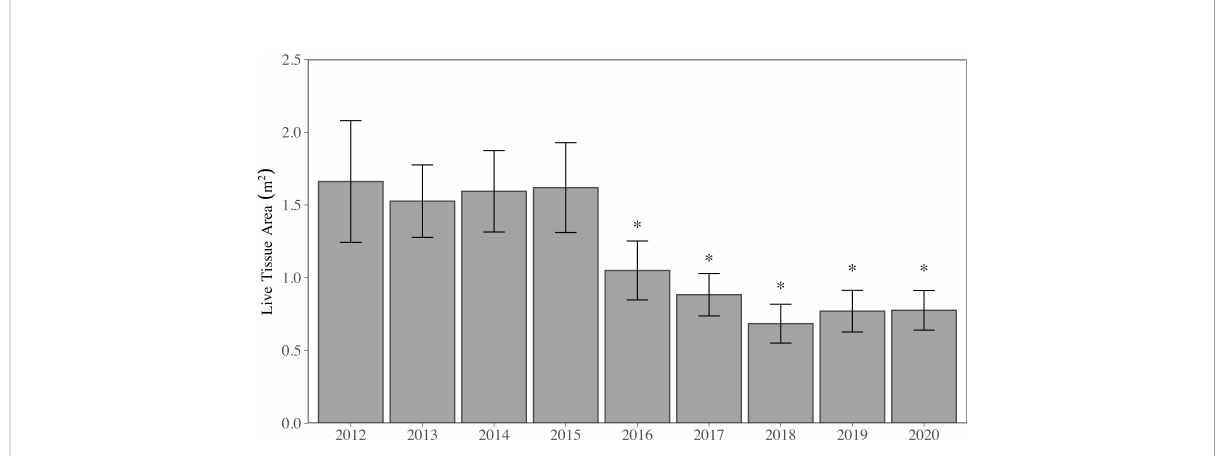
FIGURE 2 Mean (± SE) annual live tissue area (LTA) for all stony coral species and sites combined. Years with asterisks (*) are signi fi cantly different from those without asterisks (*) but are not signi fi cantly different from each other (p < 0.05,